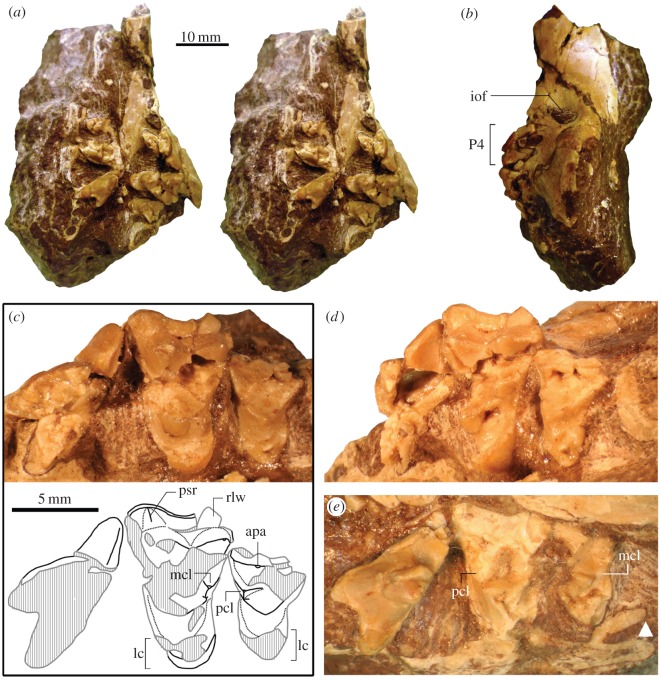
Upper dentition of Angelarctocyon australis, gen. et comb. nov. (holotype FMNH PM 423). (a) Block of matrix containing right and left maxillae (stereo pair in occlusal view; note anteroposteriorly rotated right maxilla); (b) left facial region in lateral view (anterior to top); (c) left P4–M2 in occlusal view (shaded areas of line drawing indicating damaged surfaces; black lines represent original borders); (d) same in oblique posterior view; (e) right P4–M2 (inverted; white triangle points to minimum posterior extent of maxilla). Same scale bar applies to a and b, and c–e. Abbreviations: apa, apex of paracone; iof, infraorbital foramen; lc, lingual portion of lingual cingulum; mcl, metaconule; pcl, paraconule; psr, parastylar ridge; rlw, broken piece of rotated labial wall.